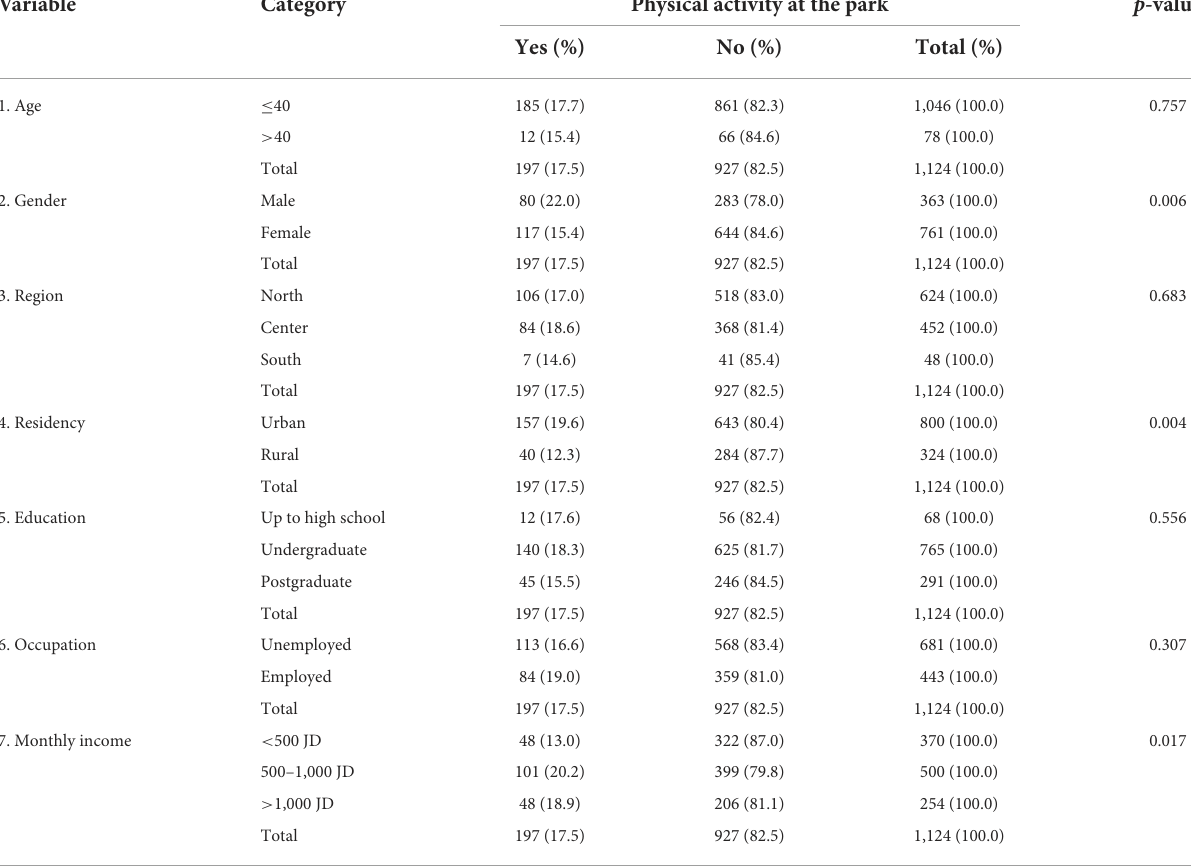
TABLE 3 Distribution of socio-demographic variables by physical activity at the park among study participants ( N = 1,124).